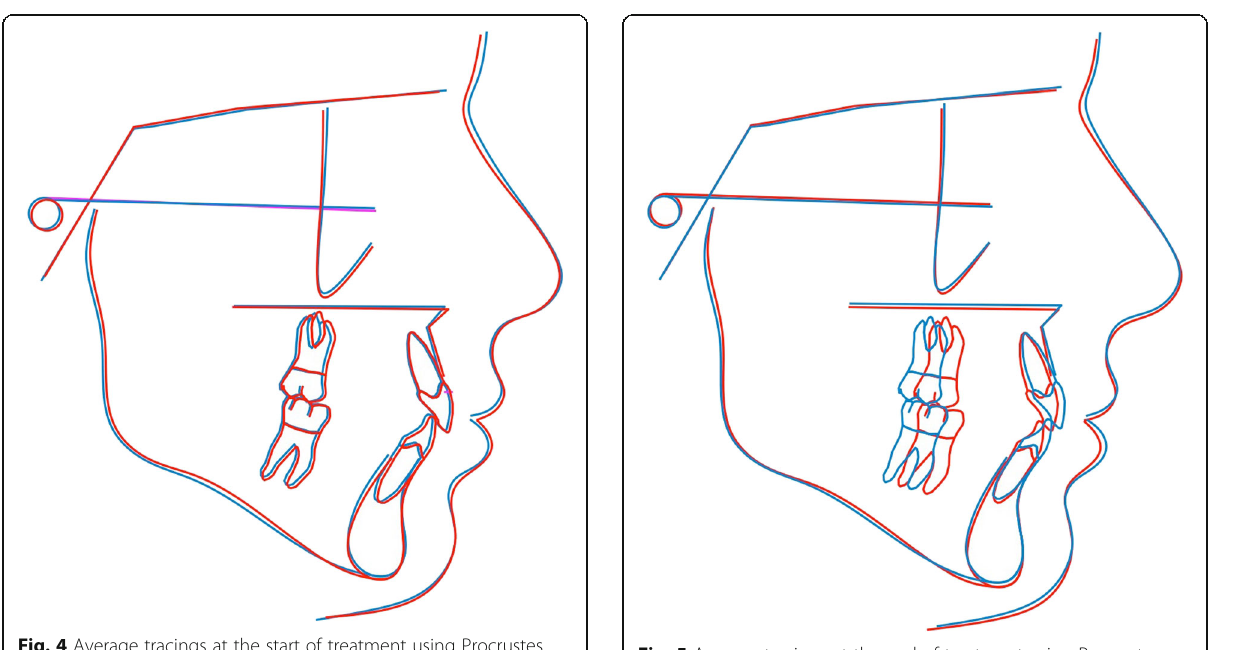
Fig. 5 Average tracings at the end of treatment using Procrustes superimposition. Blue line, non-extraction; red line,